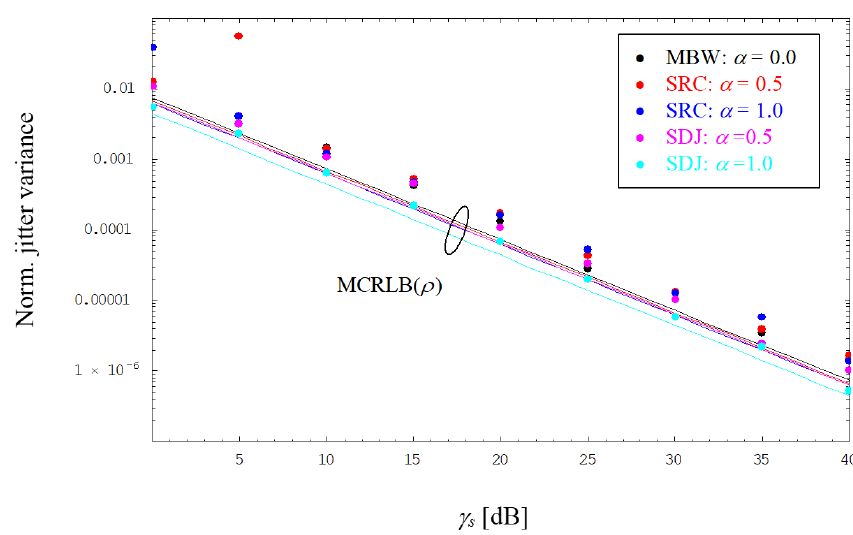
Figure 8. Normalized jitter variance for amplitude estimates (FF receiver).